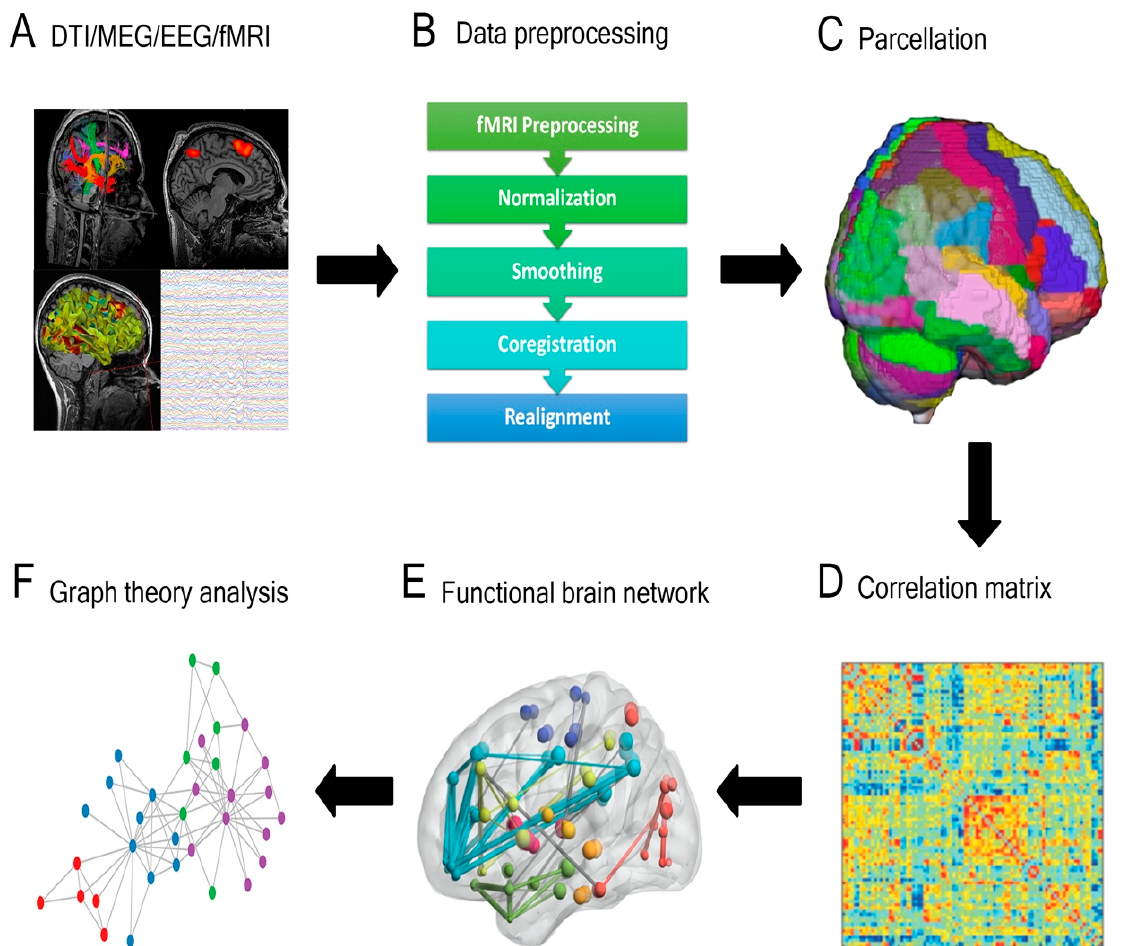
Figure 1. General overview of a connectivity analysis pipeline. ( A ) Structural or functional data are acquired and ( B ) pre- processed, then ( C ) parcellated by dividing the brain into distinct regions. A ( D ) correlation matrix is then created to estimate the connectedness between regions and ( E ) functional brain networks are generated. ( F ) Graph theory analysis is applied to delineate nodes, edges, and central hubs. (DTI = diffusion tensor imaging; MEG = magnetoencephalography; EEG = electroencephalography; Fmri = functional magnetic resonance imaging).